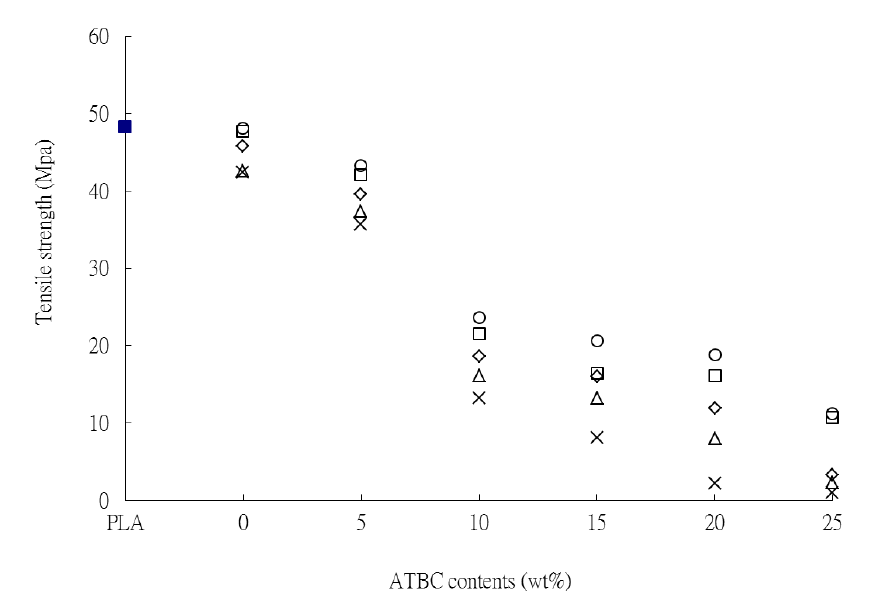
Figure 2. Tensile strength vs. ATBC content for ( ■ ) PLA; (○) PLA (□) PLA (×) PLA